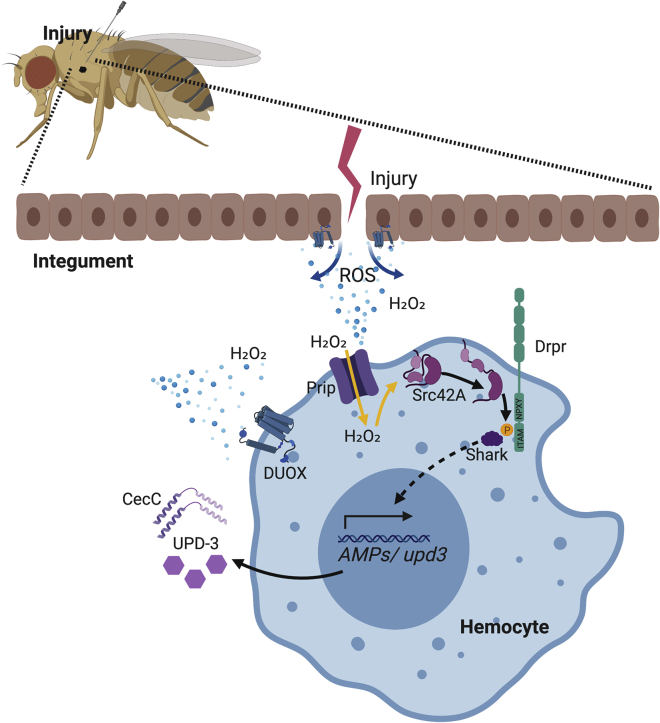
Features of a Response to Systemic Injury in FliesFollowing injury, hemocytes respond to the damage signal H2O2, which is produced by the NADPH oxidase Duox, through the kinase Src42A and its downstream targets Shark and Draper. A channel protein, Prip, helps increase intracellular ROS levels within hemocytes to trigger the Toll and JAK/STAT signaling pathways, contributing to trained immunity.